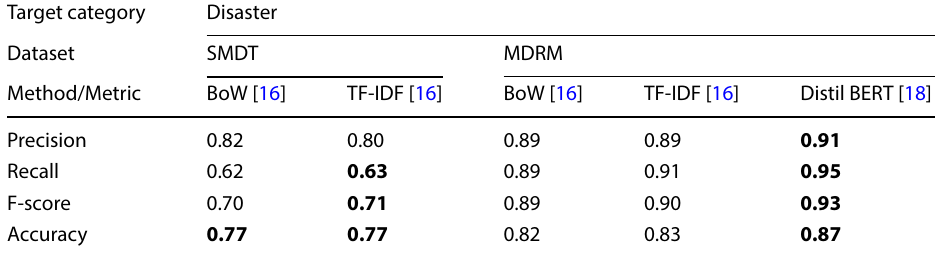
*The DistilBERT method is not applied to the SDMT dataset due to its reduced number of total